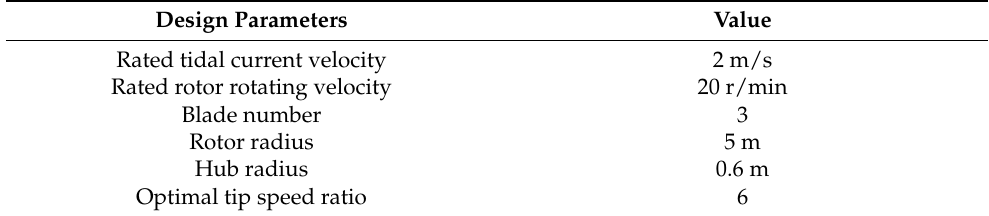
Figure 4. Blade profile of the 120 kW tidal current turbine: ( a ) blade profile; ( b ) detailed airfoil element section. Table 1. 120 kW tidal current turbine design parameters.